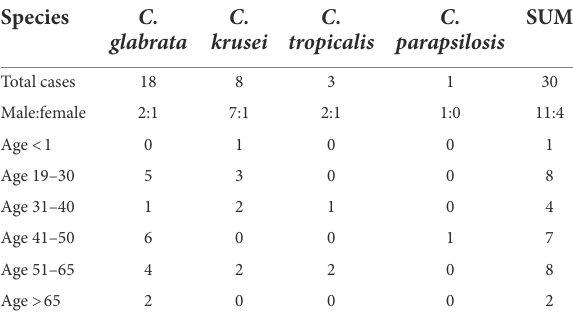
TABLE 2 Occurrence of non- Candida albicans species in different age groups and gender.